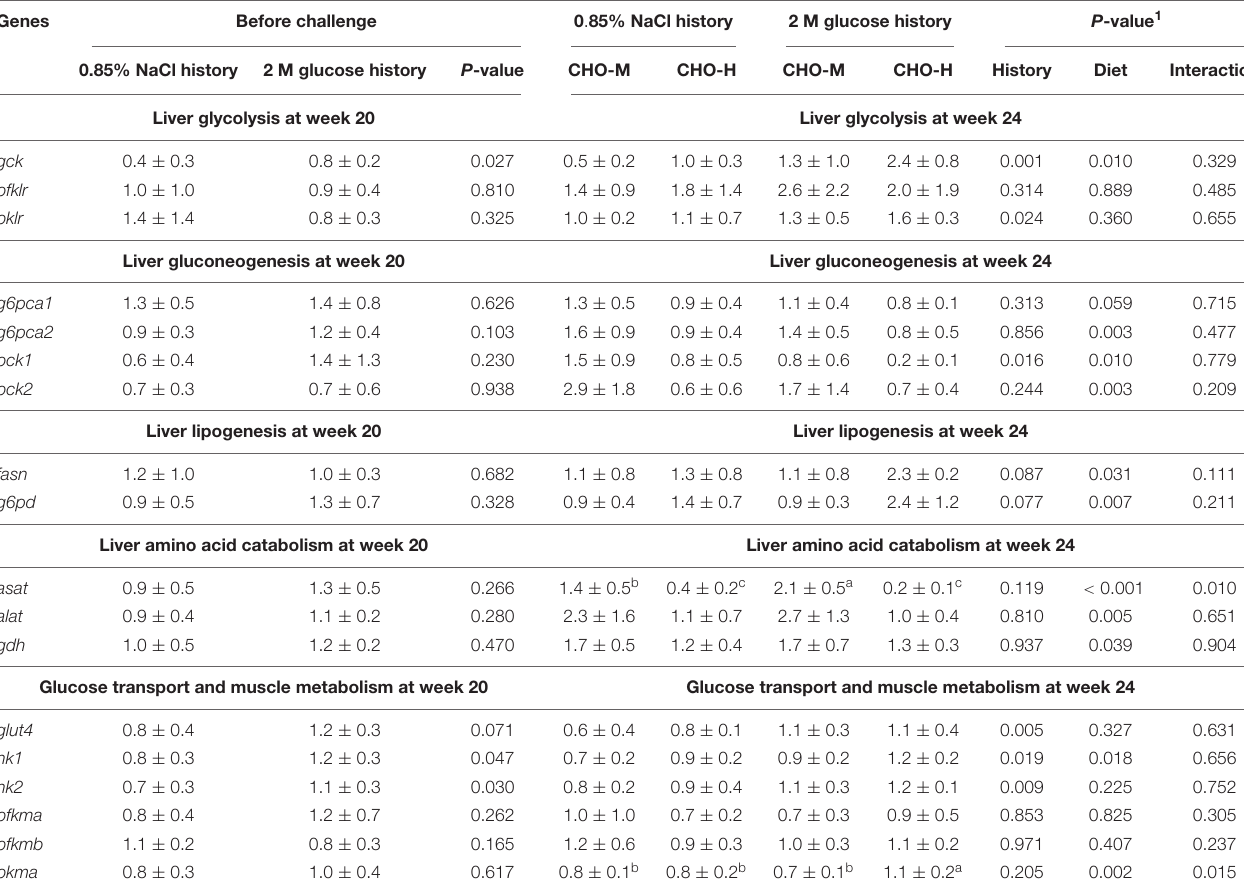
TABLE 4 | mRNA levels of genes involved in carbohydrate metabolism in the liver and muscles of fish injected with saline (0.85% NaCl) and glucose (2 M) before (20 wpi) and after (24 wpi) challenging with CHO-M and CHO-H for 4 weeks (mean ± SD, n = 6). Genes Before challenge 0 . 85% NaCl